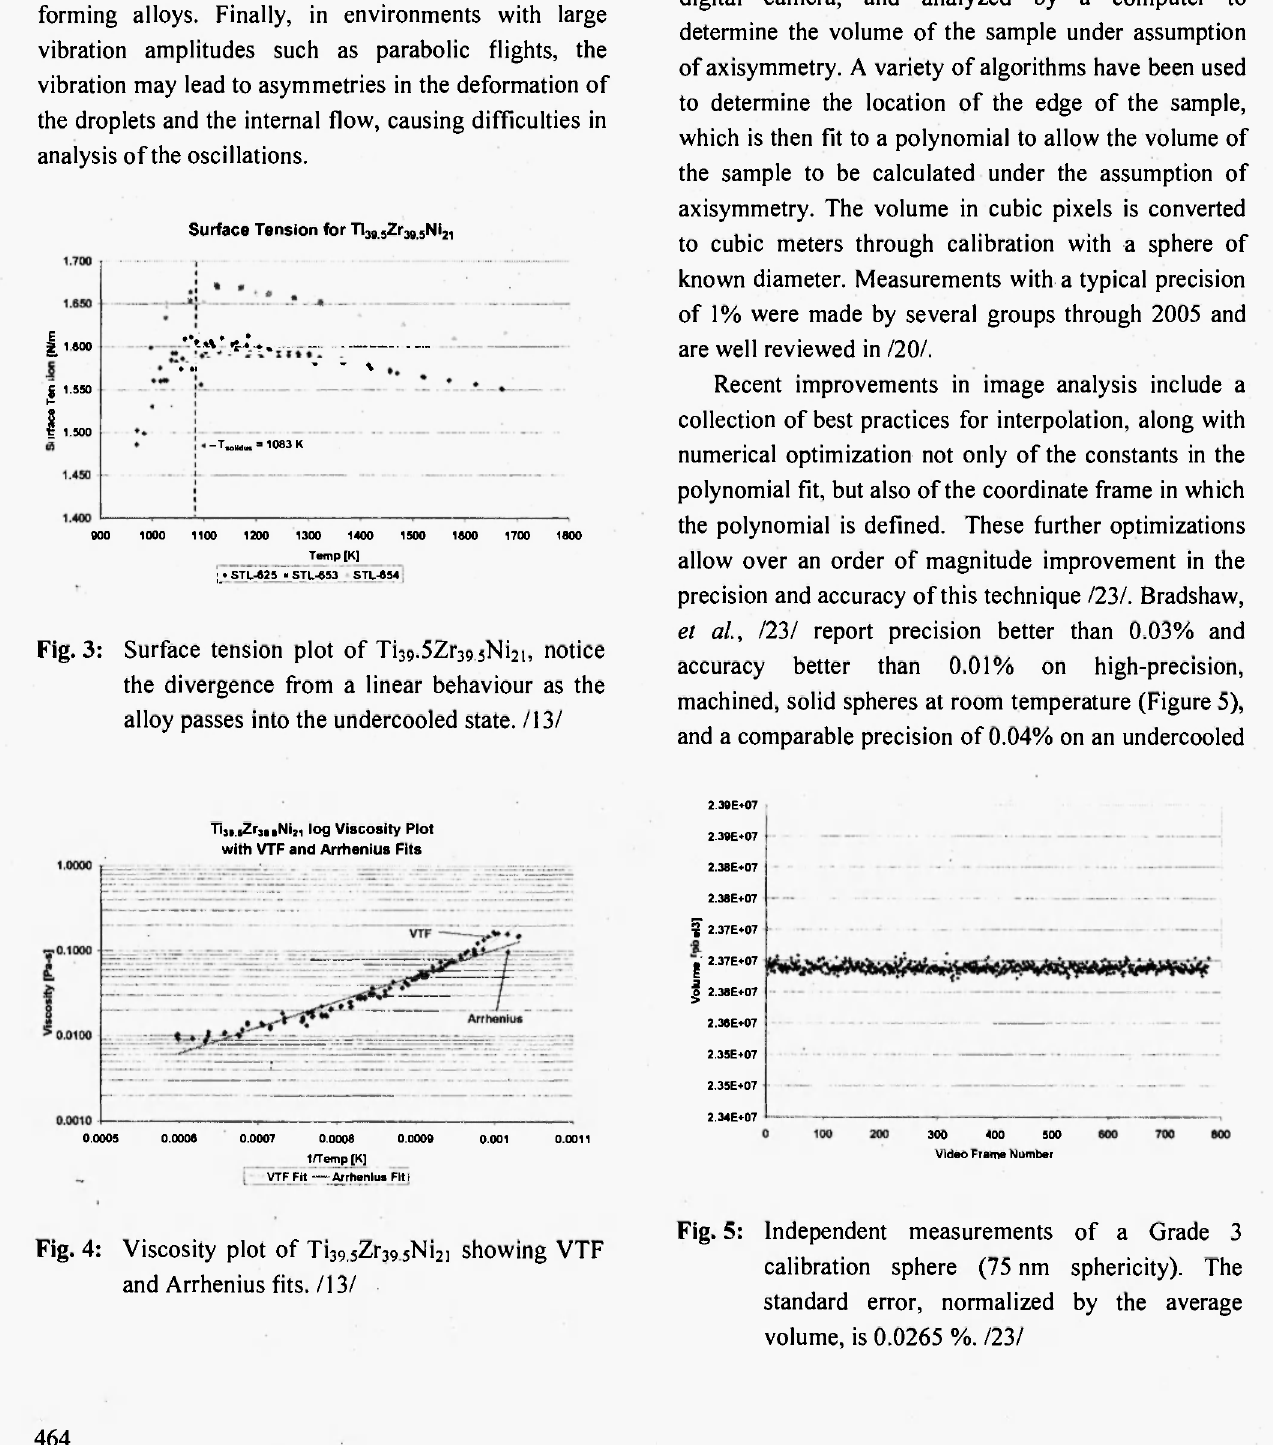
Fig. 4: Viscosity plot of Ti 39 5Zr 39 5Ni 2 ] showing VTF and Arrhenius fits. /13/